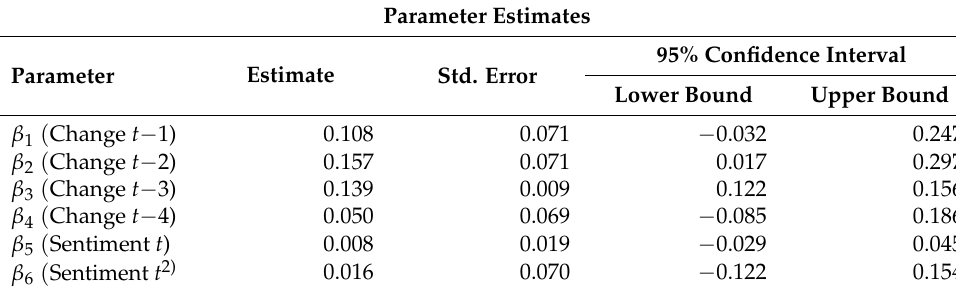
Table 6. Estimators for the NARX model.